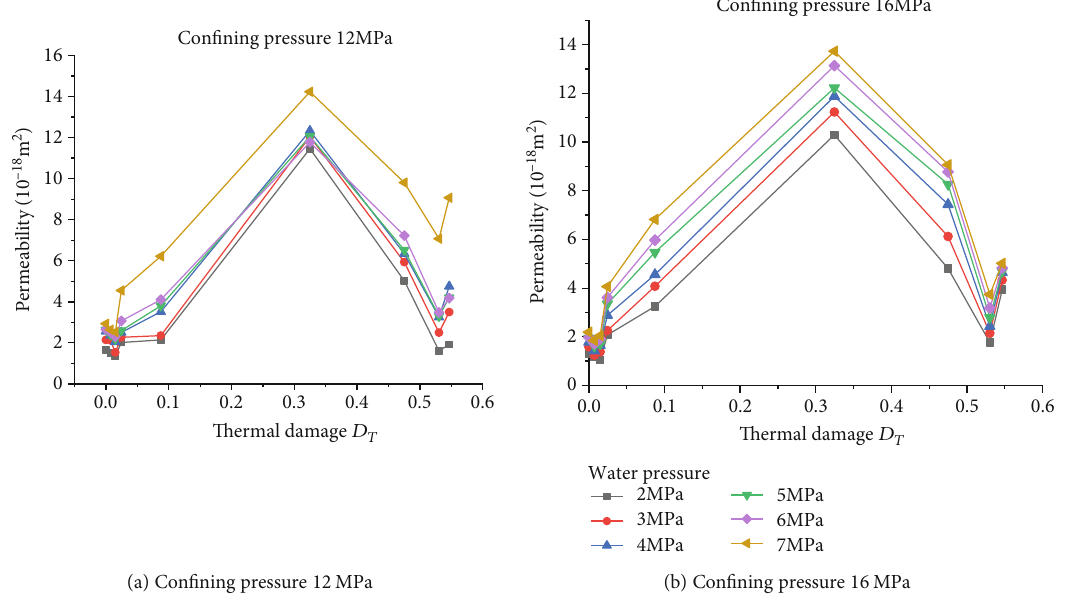
Figure 13: Comparison of the permeability and the thermal damage